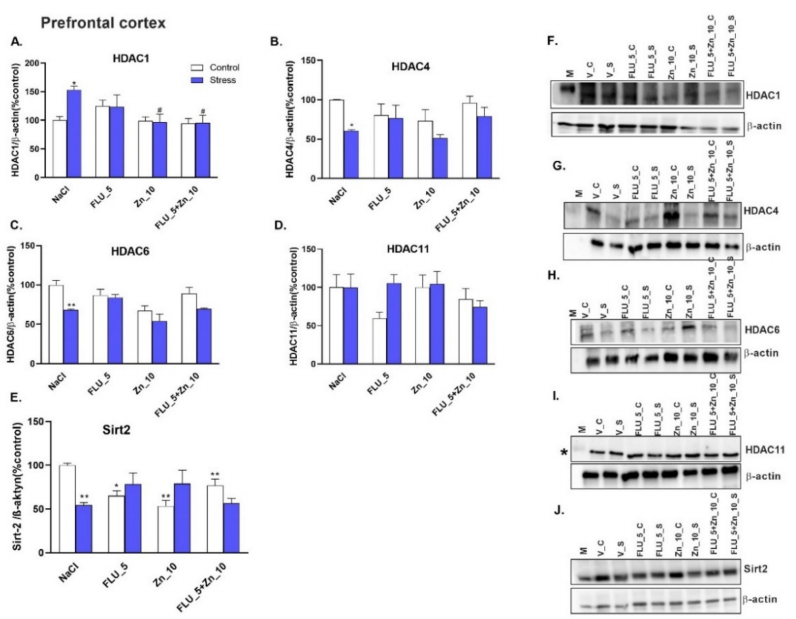
Figure 8. The combined effect of Zn supplementation and FLU treatment on protein levels of HADC1 ( A ), HADC4 ( B ), HDAC6 ( C ), HDAC 11 ( D ), and Sirt2 ( E ) in the PFC of CRS-treated mice. All data were analyzed by two-way ANOVA and Newman–Keuls multiple comparison test. Values are expressed as mean ± SEM; n = 4–7. * p < 0.05, ** p < 0.01 vs. NaCl; # p < 0.05 vs. CRS + NaCl. (F–J) Representative Western blots. * images from the same membrane (see Figure 5).